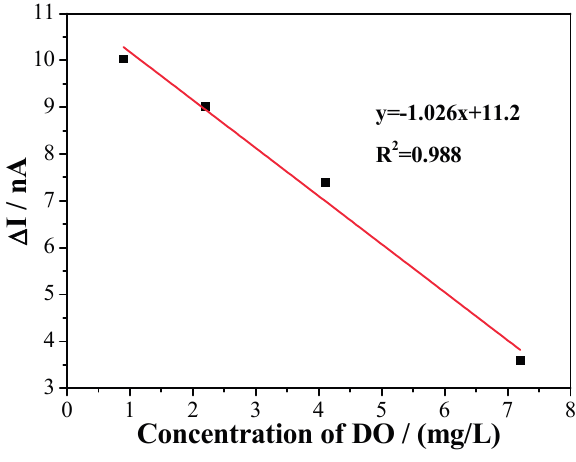
Figure 9. The linear range of DO